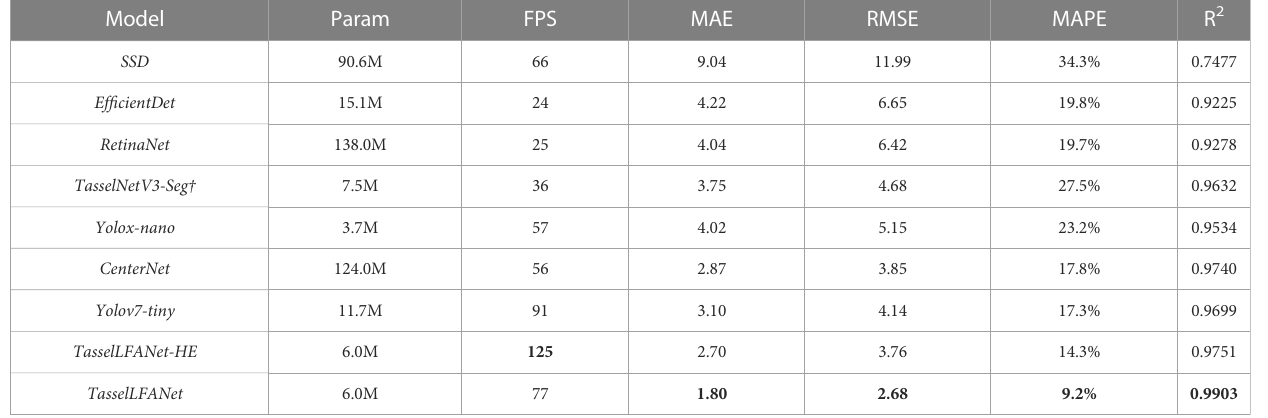
TABLE 6 Counting performance comparison of different